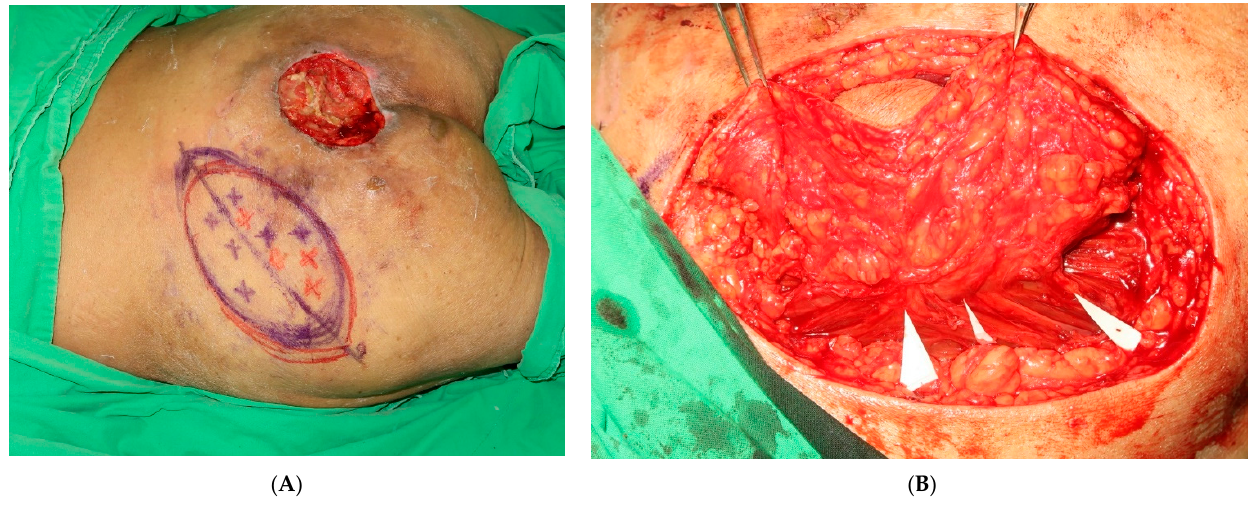
Figure 2. ( A ) The superior gluteal artery (SGA) and its perforators were identified with ICGFA and ADS. ( B ) The purple marks represent perforators detected by ICGFA; The red marks represent perforators detected by ADS.